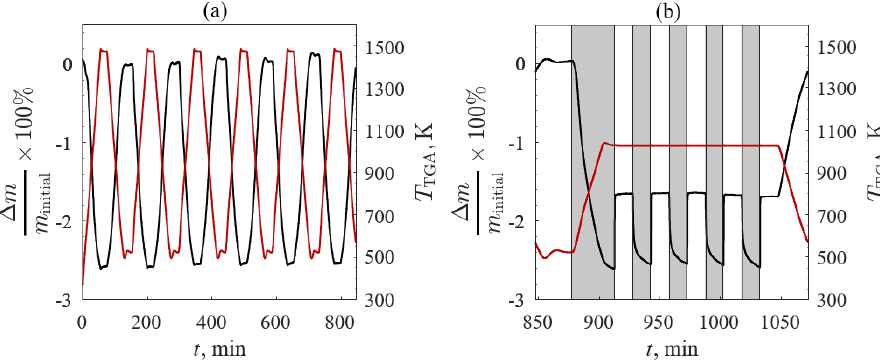
Figure9. Relativemasschange(blackline)andtemperature(redline)versustimeforBa 0.1 Sr 0.9 Co 0.1 Fe 0.9 Figure 9. Relative mass change (black line) and temperature (red line) versus time for O 3 − δ with five reduction / oxidation cycles with the ( a ) temperature-swing from 523 and 1473 K in 20% Ba 0.1 Sr 0.9 Co 0.1 Fe 0.9 O 3−δ with five reduction/oxidation cycles with the ( a ) temperature-swing from 523 O 2 / Ar and ( b ) O 2 pressure-swing from 20% O 2 / Ar to 100% Ar (gray region) O 2 / Ar at 1023 K for TGA and 1473 K in 20% O 2 /Ar and ( b ) O 2 pressure-swing from 20% O 2 /Ar to 100% Ar (gray region) O 2 /Ar Screening 3. at 1023 K for TGA Screening 3. Table 4. Relative mass change and mean and standard deviation of deviation from stoichiometry change for A- and B-site substitutions in SrFeO 3 − δ for TGA Screening 3 during the temperature- and O 2